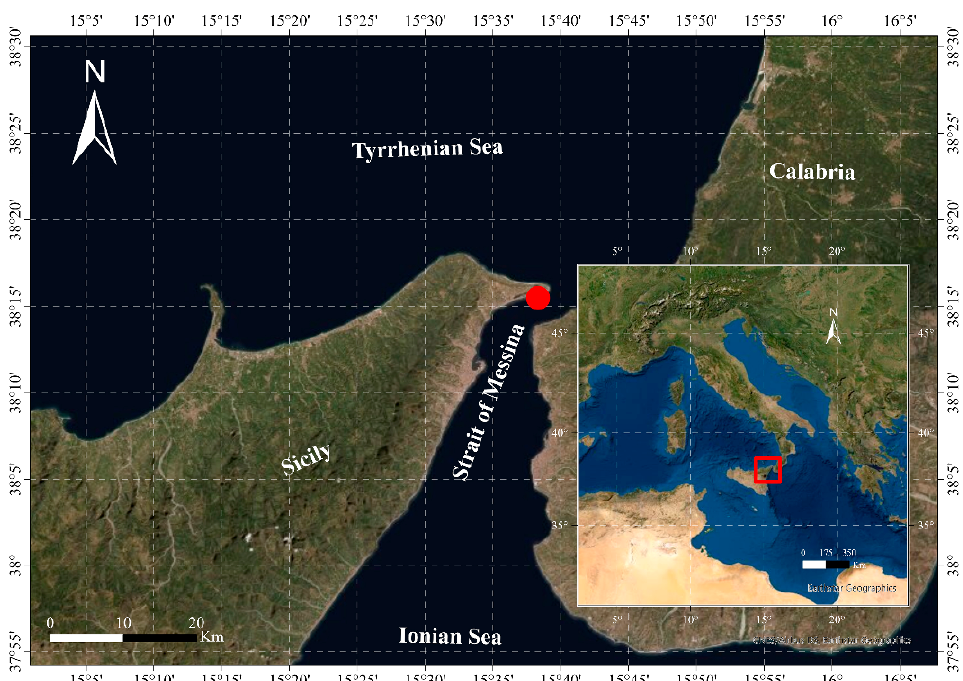
Figure 1. Study area located in the Strait of Messina.